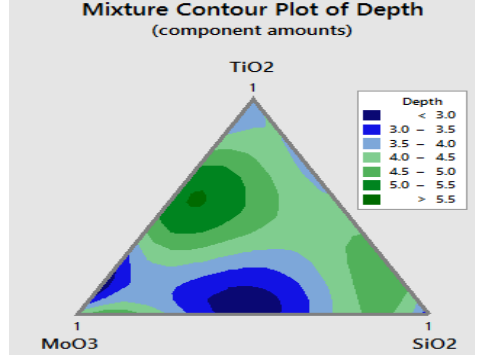
Figure 6. Mixture contour plot of depth D.